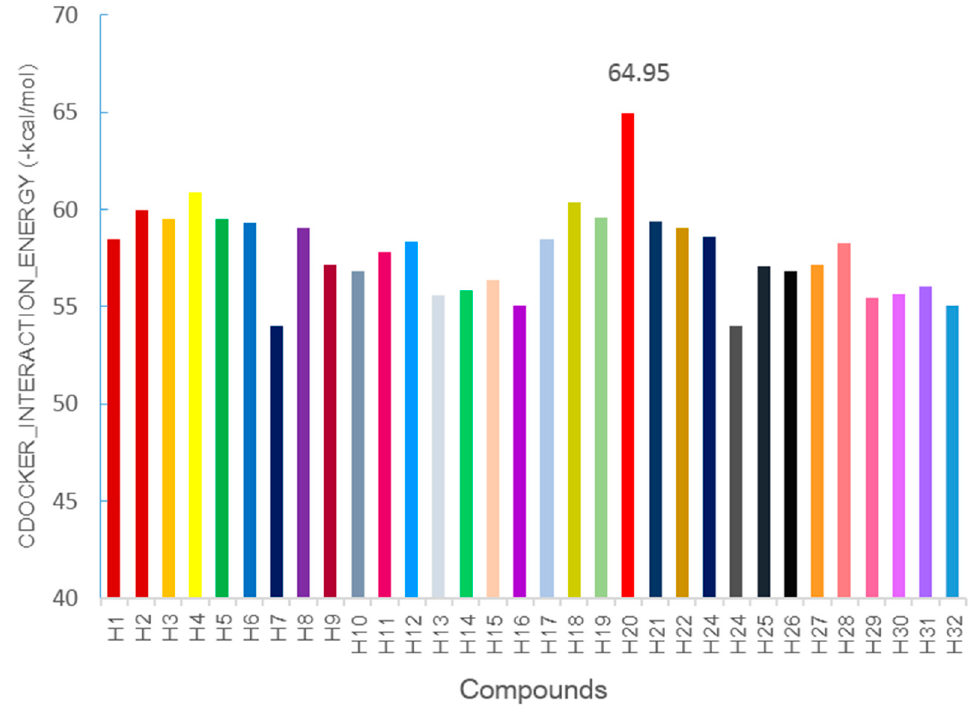
Figure 6. The histogram about CDOCKER_INTERACTION_ENERGY ( − kcal/mol) of compounds ( H1 – H32 ) for EGFR.